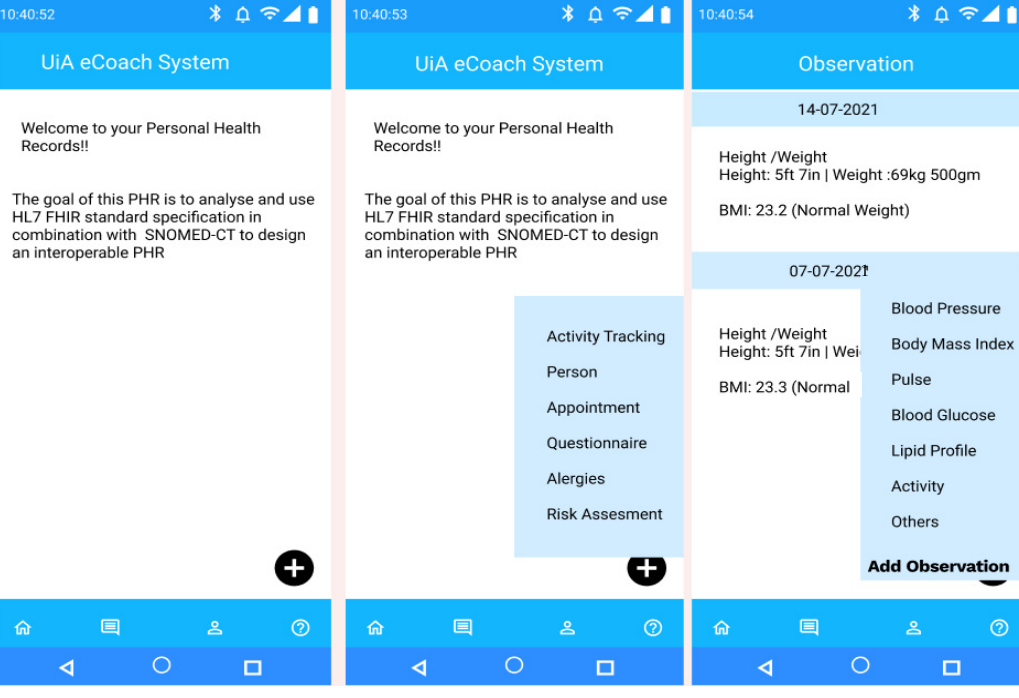
Figure 3. Landing view of the PHR mobile app and its different self-management options.